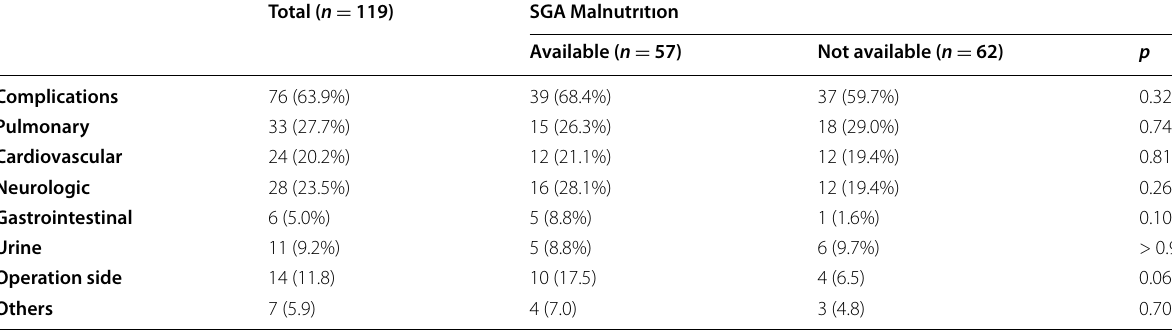
Table 5 Relationship between malnutrition and complication according to SGA